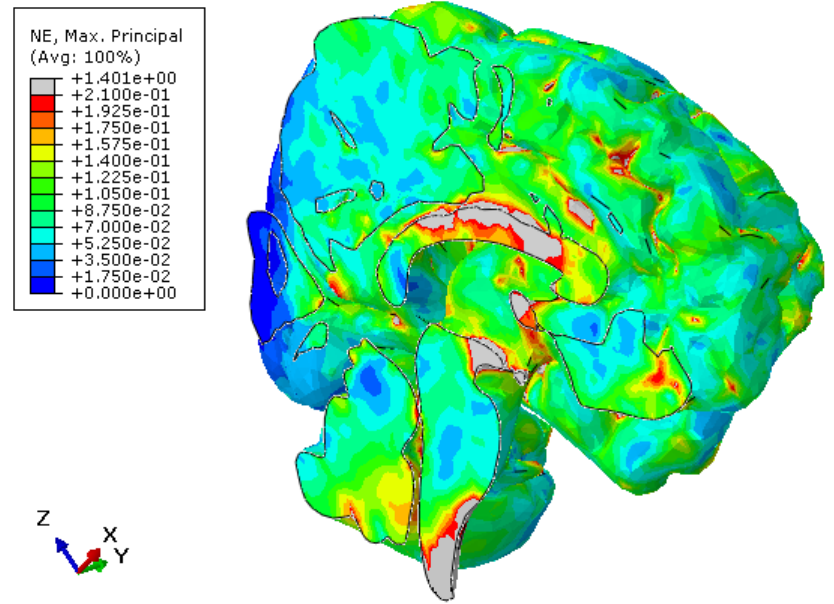
Figure 11. Sagittal plane depicting the maximum principal strain mapping (threshold of